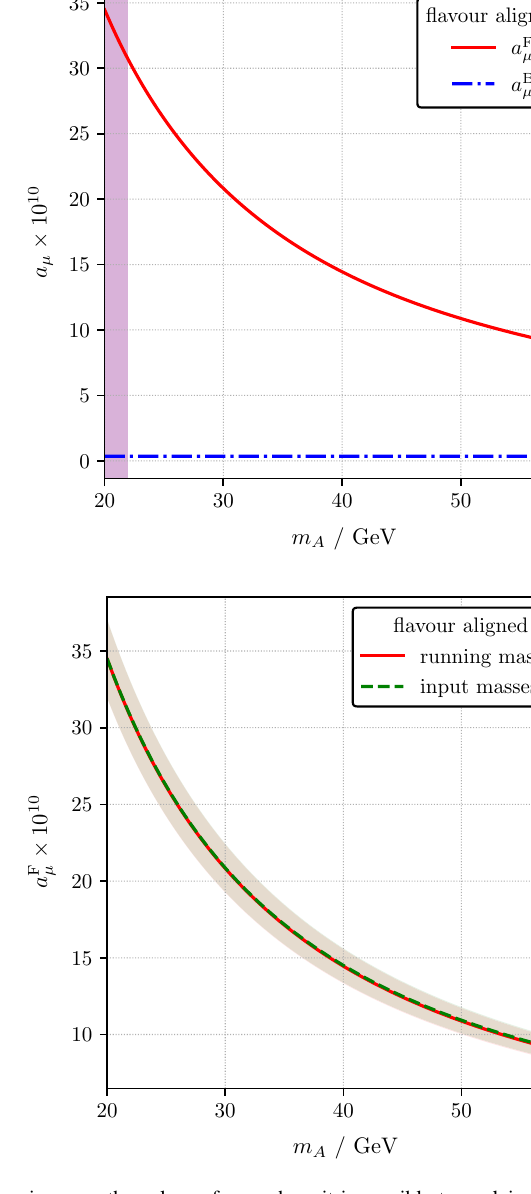
Fig. 2 Different contributions to a BSM μ in the 2HDM. In the left panels region over the values of m A where it is possible to explain Eq. (3). we show scenarios from the type II 2HDM as a function of m A with In the bottom panels we compare the fermionic two-loop contributions, m H = 400GeV , m H ± = 440GeV, tan β = 3, sin (β − α) = 0 . 999, when the running 3rd generation fermion masses shown in (73) are used λ = λ = 0 and m 2 = ( 200GeV ) 2 . In the right panels we (red solid line) and when the 3rd generation input masses from (72) are 6 7 12 used (green dashed line). The redand green bands show the correspond- show FA2HDM scenarios with m h = 125GeV, m H = 150GeV, m H ± = 150GeV, sin (β − α) = 0 . 999, λ 6 = 0, λ 7 = 0, tan β = 2, ing uncertainties. The bottom left panel also shows two-loop fermionic m 2 contributions calculated from 2HDMC as a black dotted line. *This is is fixed to avoid h → AA decays using a polynomial equation 12 not a vanilla 2HDMC calculation, the SM-Higgs-like two-loop contri- shown in the related source code, ζ u = ζ d = − 0 . 1, ζ l = 50 based on butions have been removed, and the two-loop charged Higgs Barr–Zee scenarios found for Fig. 10 of Ref. [103]. In the top panels we show contributions have been added as explained in the fermionic (red solid line) and bosonic (blue dashed-dotted line) two- loop contributions separately. The top right panel also shows a purple